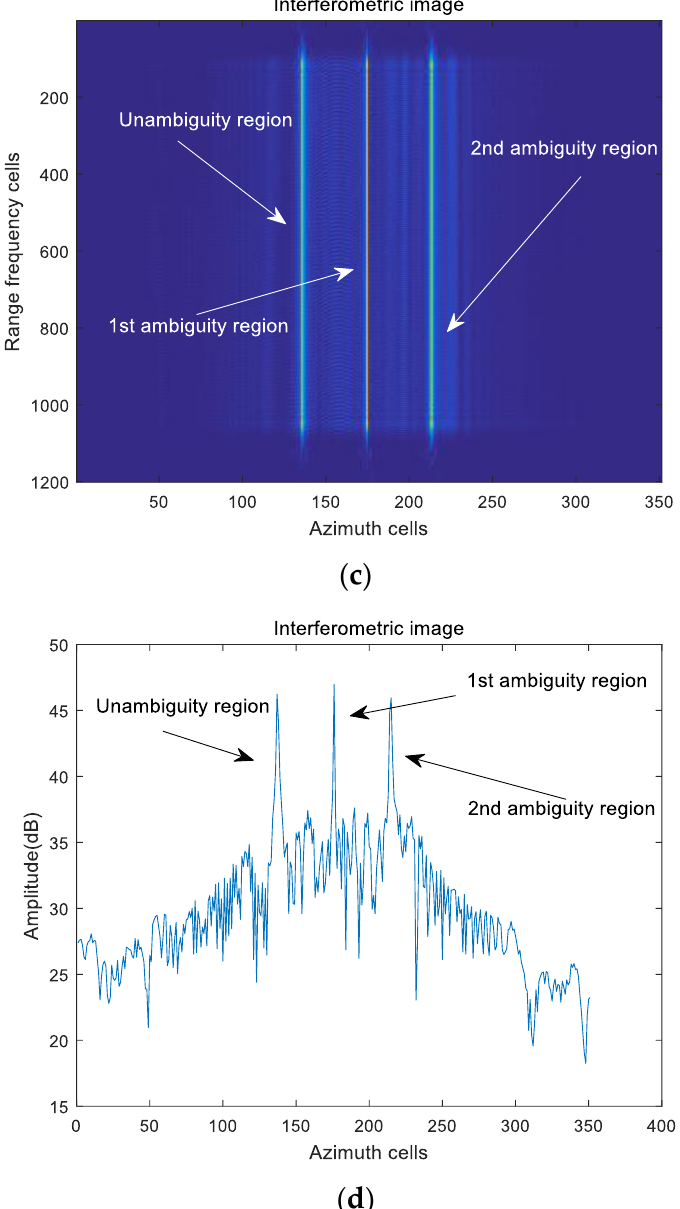
Figure 8. Interferometric images of different methods: ( a ) interferometric image using the traditional MISO-SAR; ( b ) the elevation slice diagram of the interferometric image using the traditional MISO-SAR; ( c ) interferometric image using the DDMA-SAR; ( d ) the elevation slice diagram of the interferometric image using the DDMA-SAR.